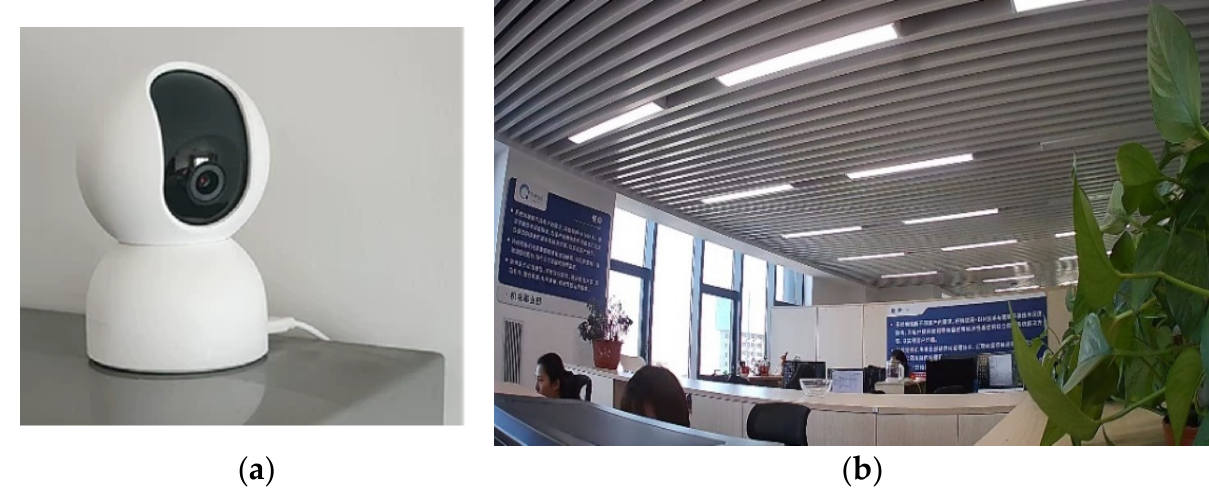
Figure 6. ( a ) Smart cameras, ( b ) camera screen.